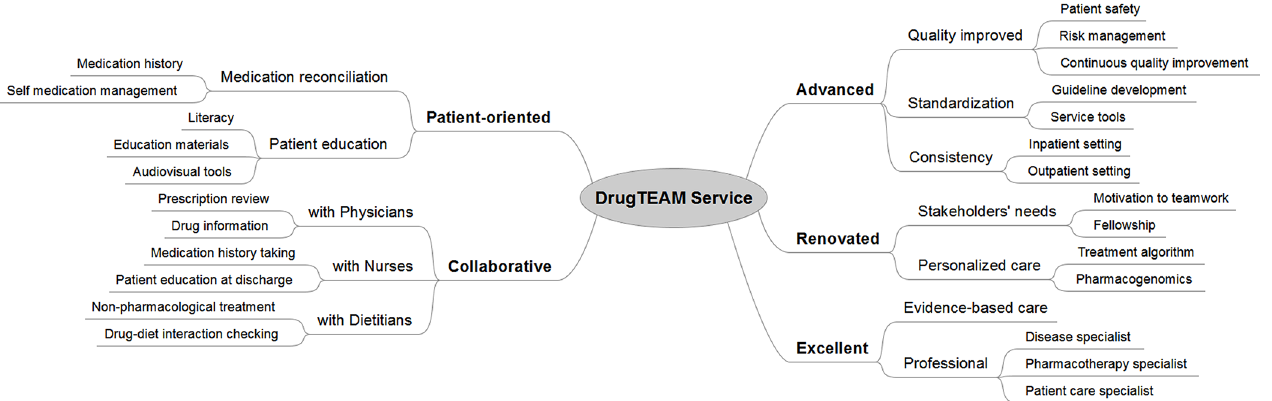
Fig 3. Service concepts based on mind mapping analysis. (Abbr.: DrugTEAM, drug therapy evaluation and management).